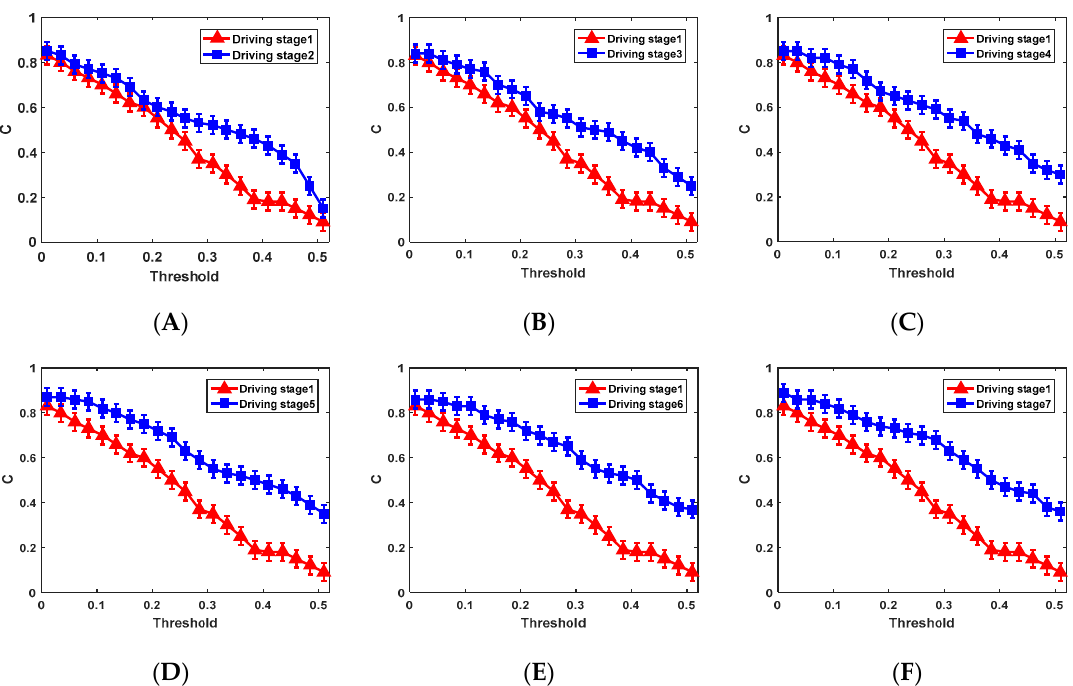
Figure 6. ( A ) Comparison of the C between driving stage 1 and driving stage 2 when the threshold value take di ff erent values; ( B ) comparison of the C between driving stage 1 and driving stage 3 when the threshold value take di ff erent values; ( C ) comparison of the C between driving stage 1 and driving stage 4 when the threshold value take di ff erent values; ( D ) comparison of the C between driving stage 1 and driving stage 5 when the threshold value take di ff erent values; ( E ) comparison of the C between driving stage 1 and driving stage 6 when the threshold value take di ff erent values; ( F ) comparison of the C between driving stage 1 and driving stage 7 when the threshold value take di ff erent